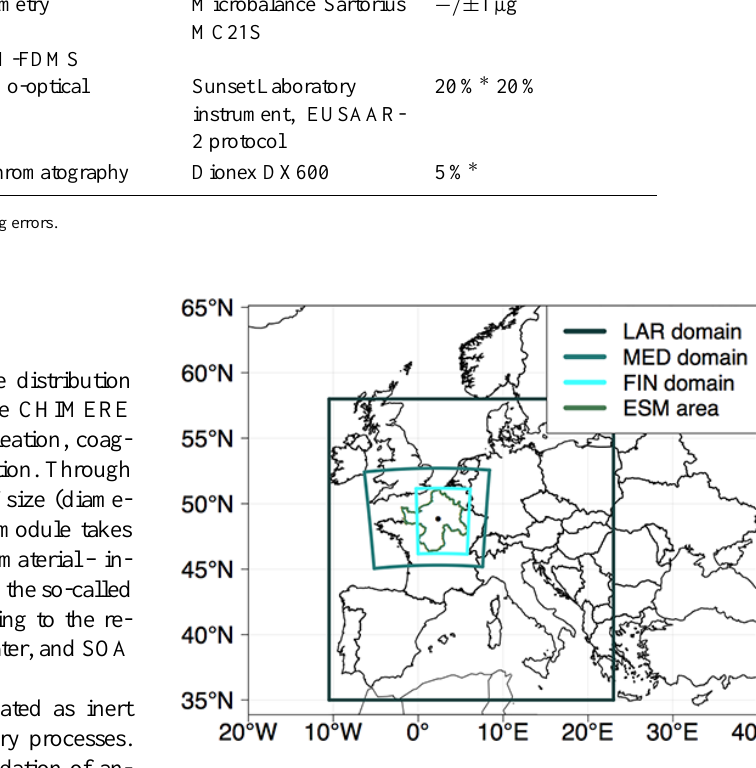
Figure 1. Nested domains used for the simulations, and ESM area of the bottom-up anthropogenic emission